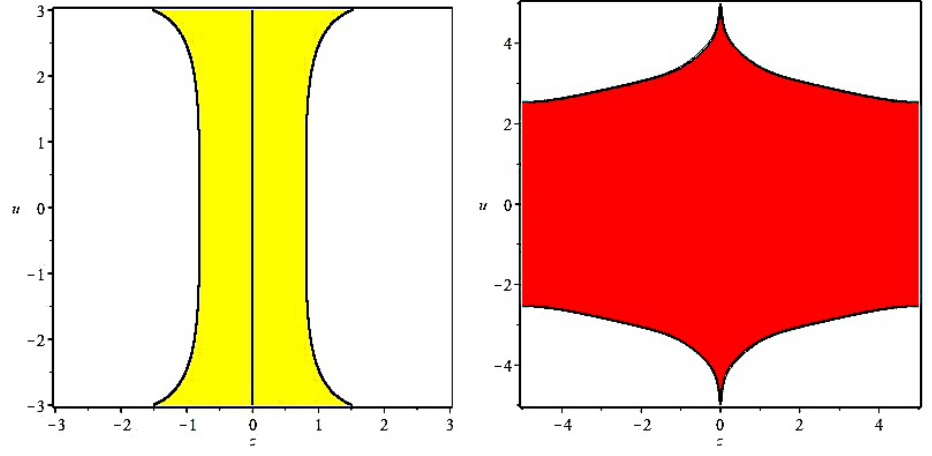
Figure 2. z − u stability region of BFFM for k = 2 ( left ) and k = 3 ( right ) for the test Equation